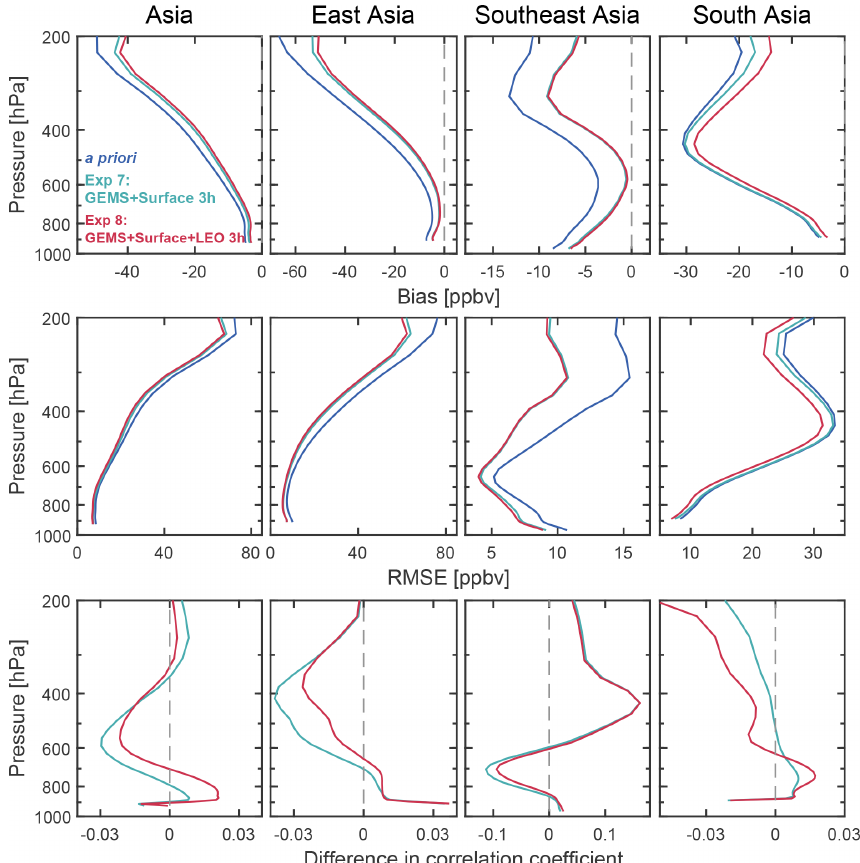
Figure 7. Ozone MBE (top panels), RMSE (middle panels), and the difference in the spatial correlation coefficient (assimilation run minus control run, bottom panels) relative to the nature run for June 2020 over the Asian domain, East Asia, Southeast Asia, and South Asia (defined in Fig. 1), as simulated by the control run (a priori) and two assimilation runs (Exp 7 and 8 in Table 1).